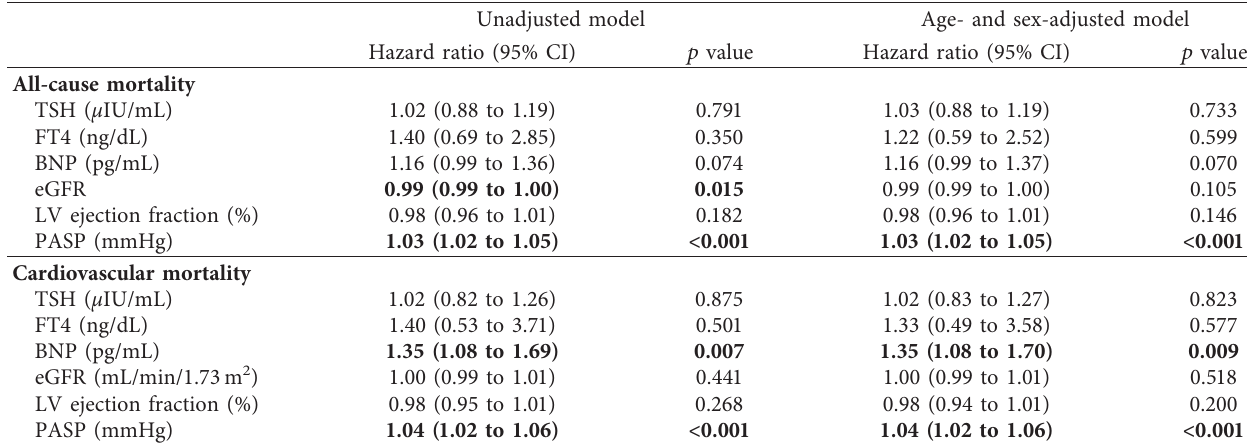
Table 4: Association between inpatient parameters and long-term clinical